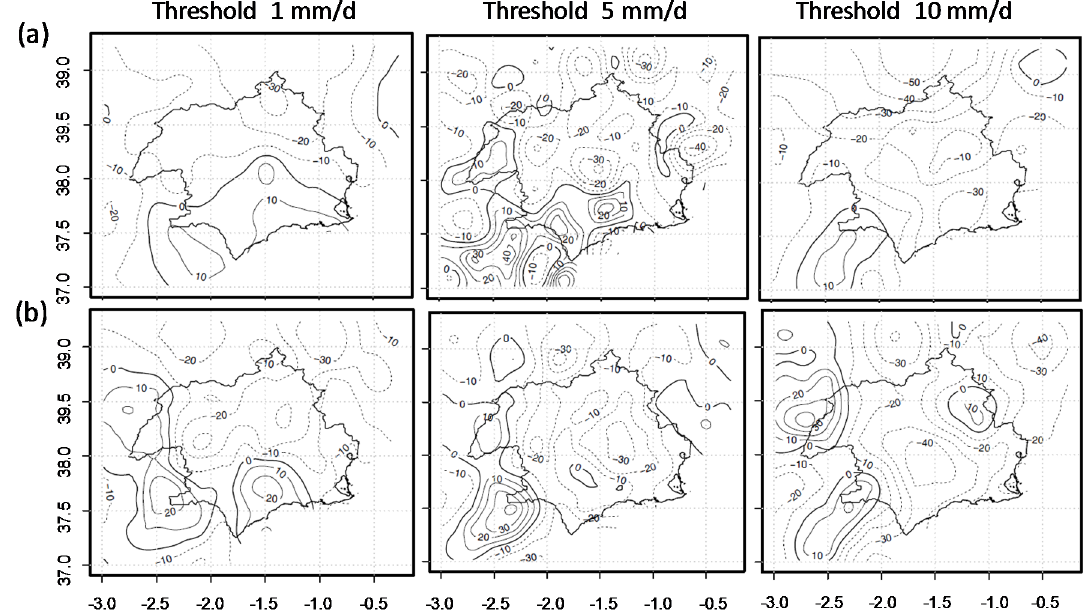
Figure 11. Spatial pattern of MDSL (days) from GAMLSS analysis on each site, for Tr = 25 years and thresholds: ( a ) 1 mm/day; ( b ) 5 mm/day; ( c ) 10 mm/day.